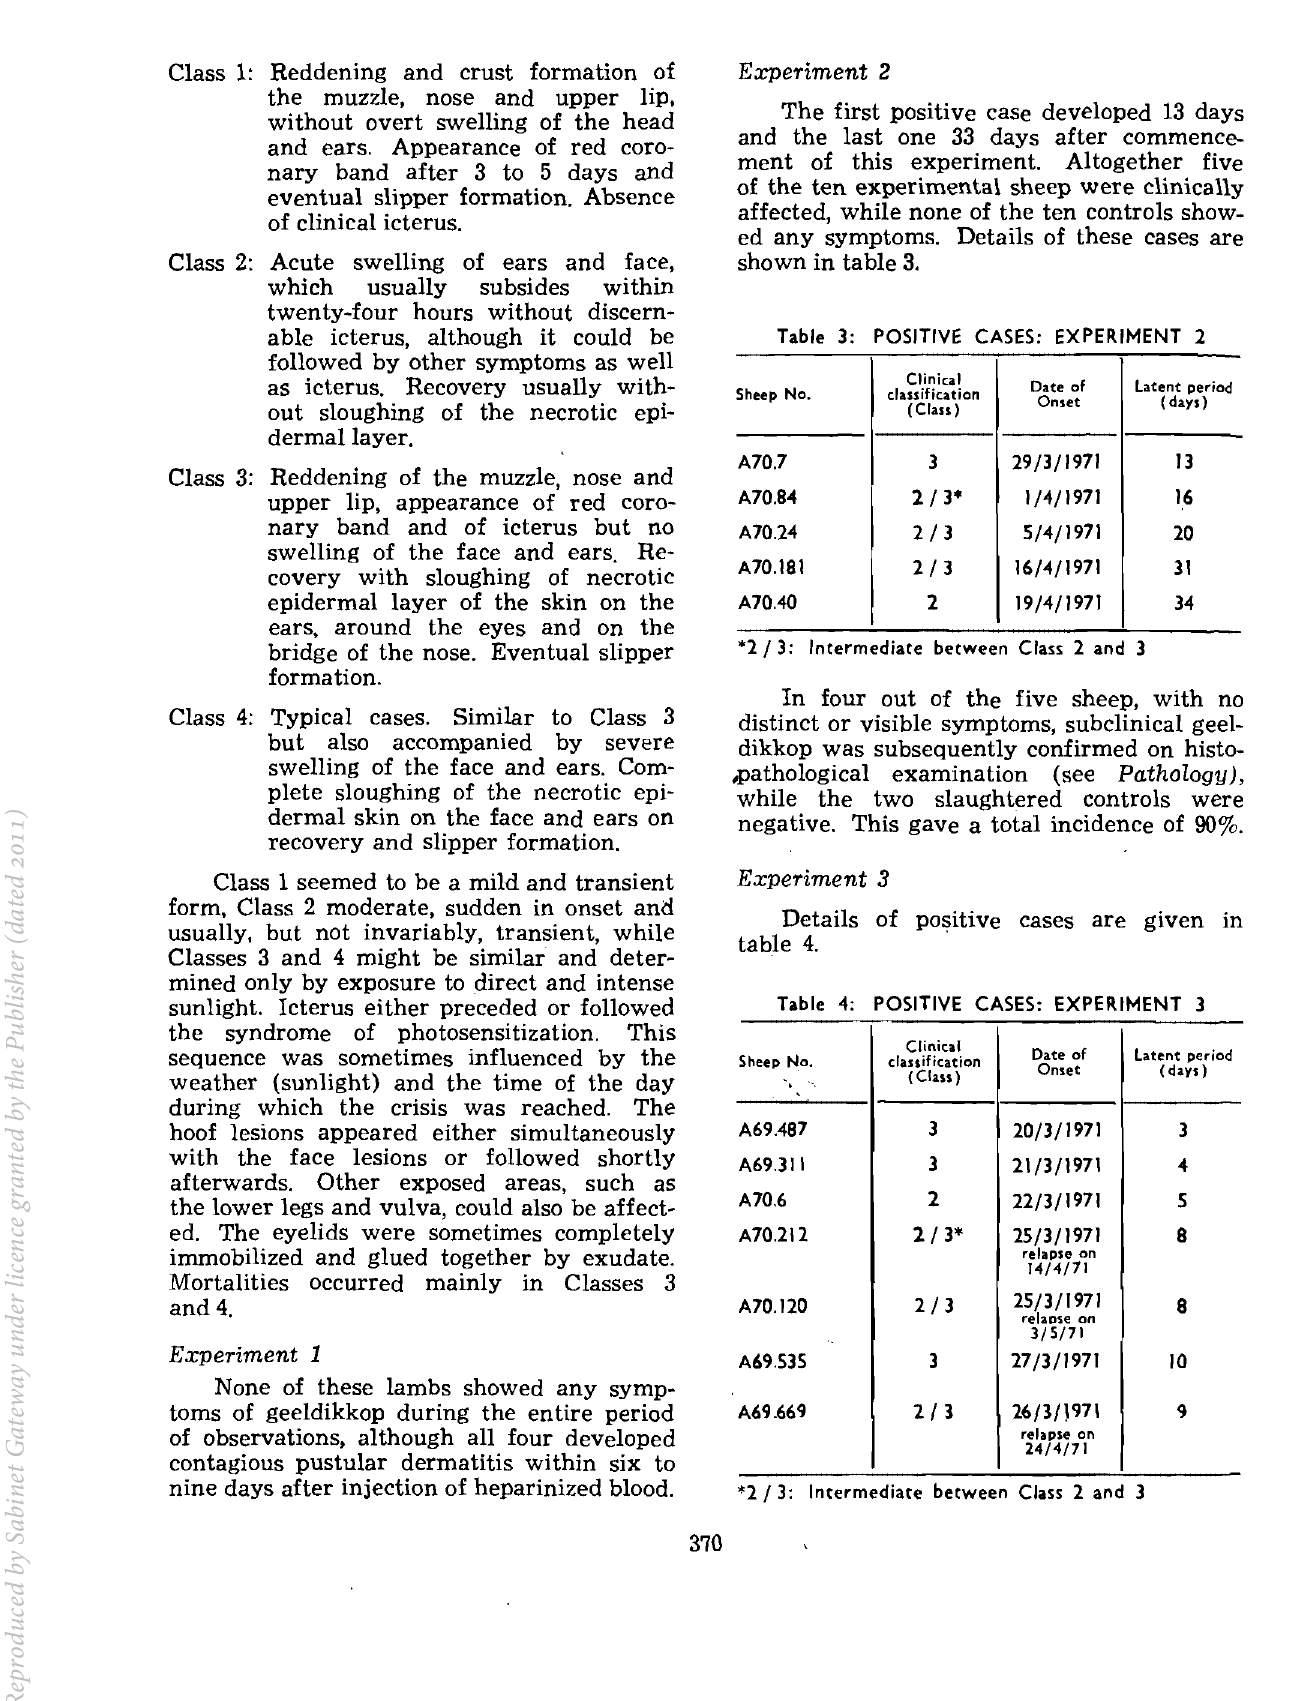
Table 4: POSITIVE CASES: EXPERIMENT